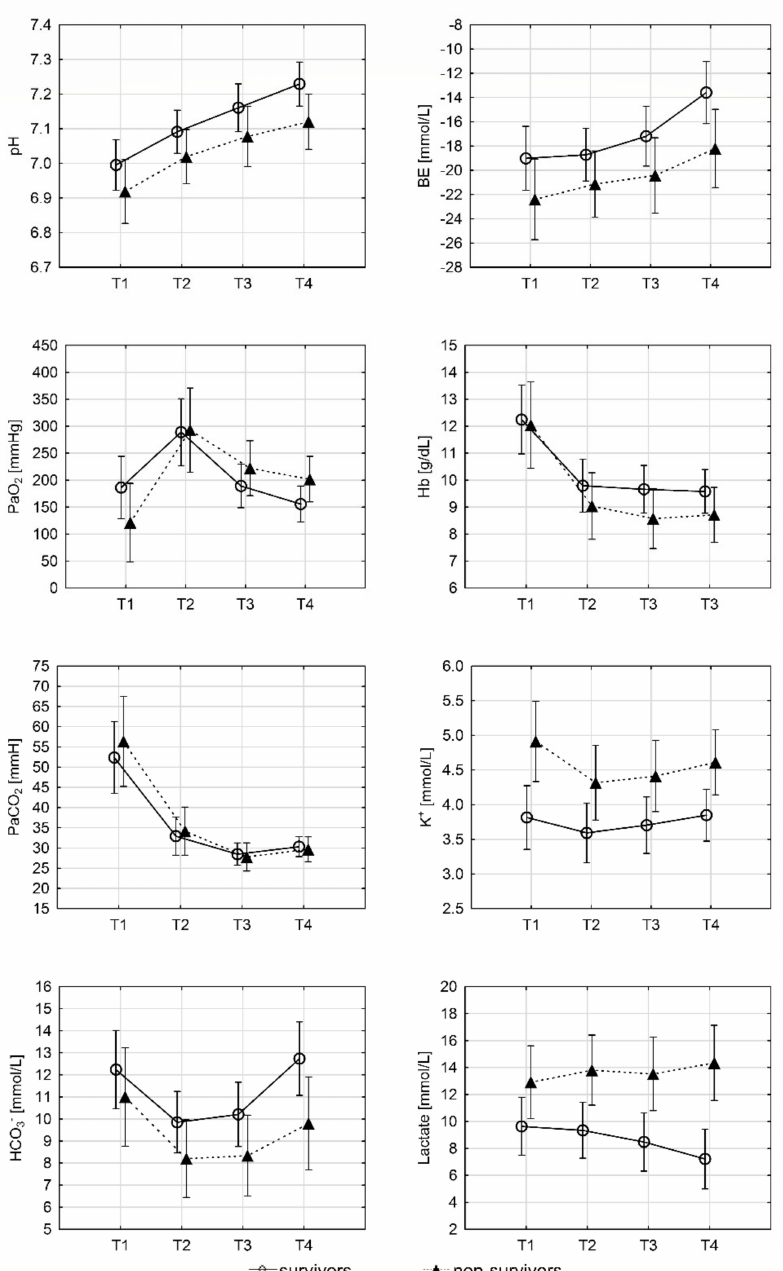
Figure 1. The mean values of blood pH, PaCO 2 , PaO 2 , HCO 3 , BE, and Hgb values are plotted at different time points. The bars represent a 95% confidence interval. T1—time at ECMO implantation, T2—time obtained Tc 30 ◦ C, T3—2 h after Tc 30 ◦ C, and T4—4 h after Tc 30 ◦ C. The survivors group blood pH was significantly higher than that of the non-survivors group at time point T4 (7.23 ± 0.16 vs. 7.12 ± 0.17; p = 0.037). There was no statistically significant difference in PaO 2 and PaCO 2 values between the groups at any time point. A significantly higher HCO 3 concentration was observed in the survivors group at time point T4 (12.70 ± 4.42 vs. 9.80 ± 4.07; p = 0.03). The survivors also had a significantly higher BE than non-survivors at time point T4 ( − 13.60 ± 6.55 vs. − 18.20 ± 6.69; p = 0.029). The serum potassium concentrations were significantly lower in the survivors group at all time points. However, these concentrations did not change significantly in the consecutive time